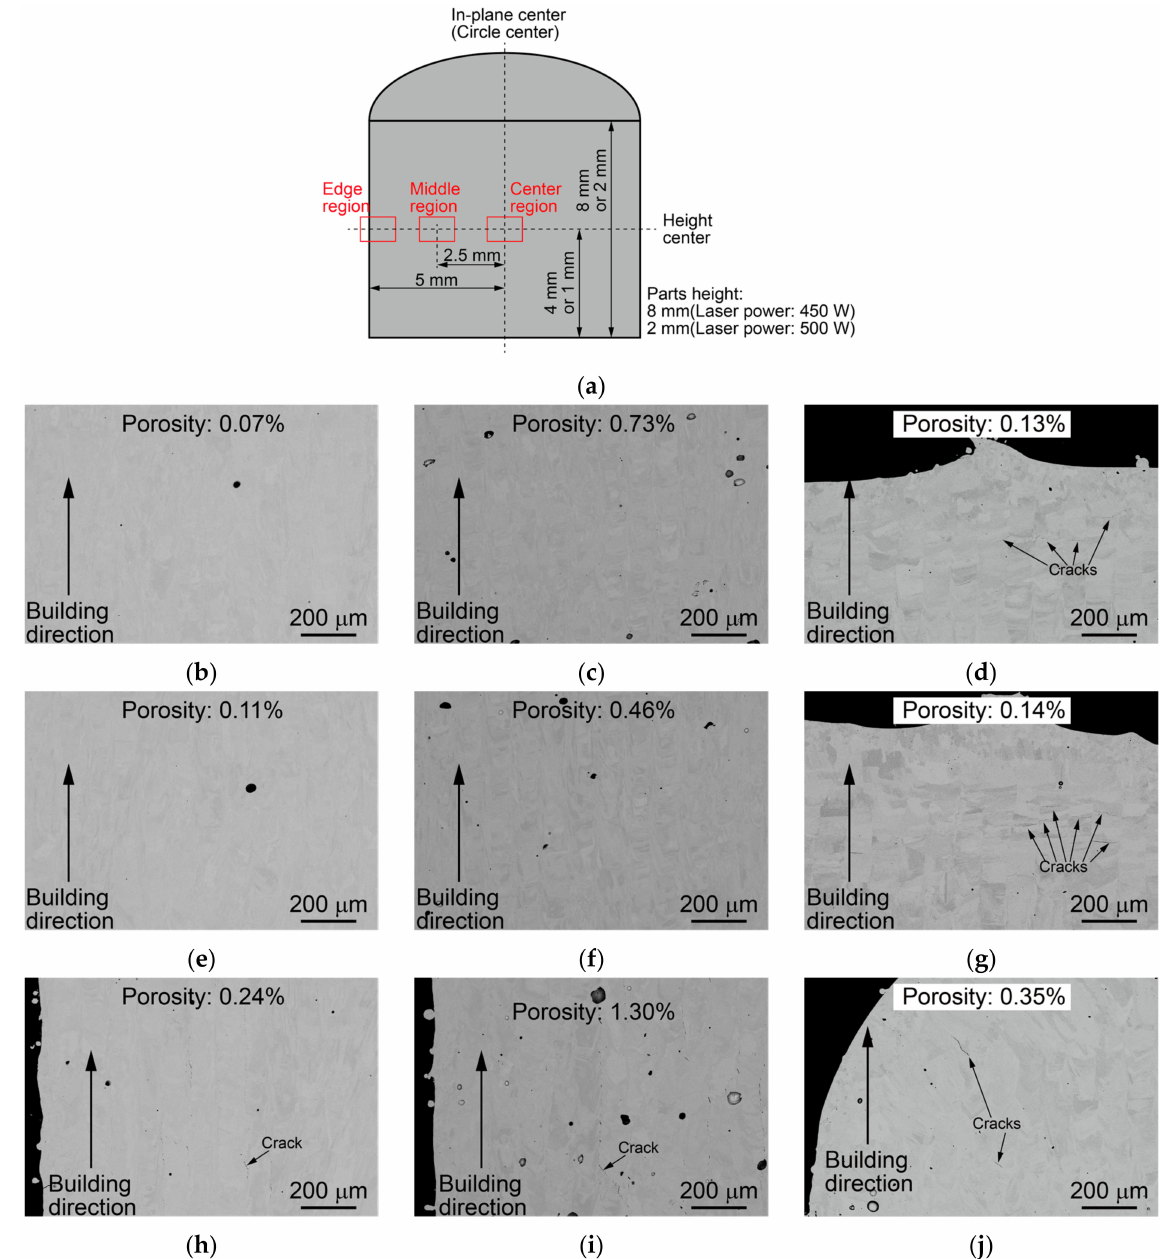
Figure 13. Results of the cross-sectional observation of cylindrical parts: ( a ) cross-sectional observation region. ( b ) Laser power: 450 W, Scan speed: 900 mm/s, center region; ( c ) Laser power: 450 W, Scan speed: 700 mm/s, center region; ( d ) Laser power: 500 W, Scan speed: 833 mm/s, center region; ( e ) Laser power: 450 W, Scan speed: 900 mm/s, middle region; ( f ) Laser power: 450 W, Scan speed: 700 mm/s, middle region; ( g ) Laser power: 500 W, Scan speed: 833 mm/s, middle region; ( h ) Laser power: 450 W, Scan speed: 900 mm/s, edge region; ( i ) Laser power: 450 W, Scan speed: 700 mm/s, edge region; ( j ) Laser power: 500 W, Scan speed: 833 mm/s, edge